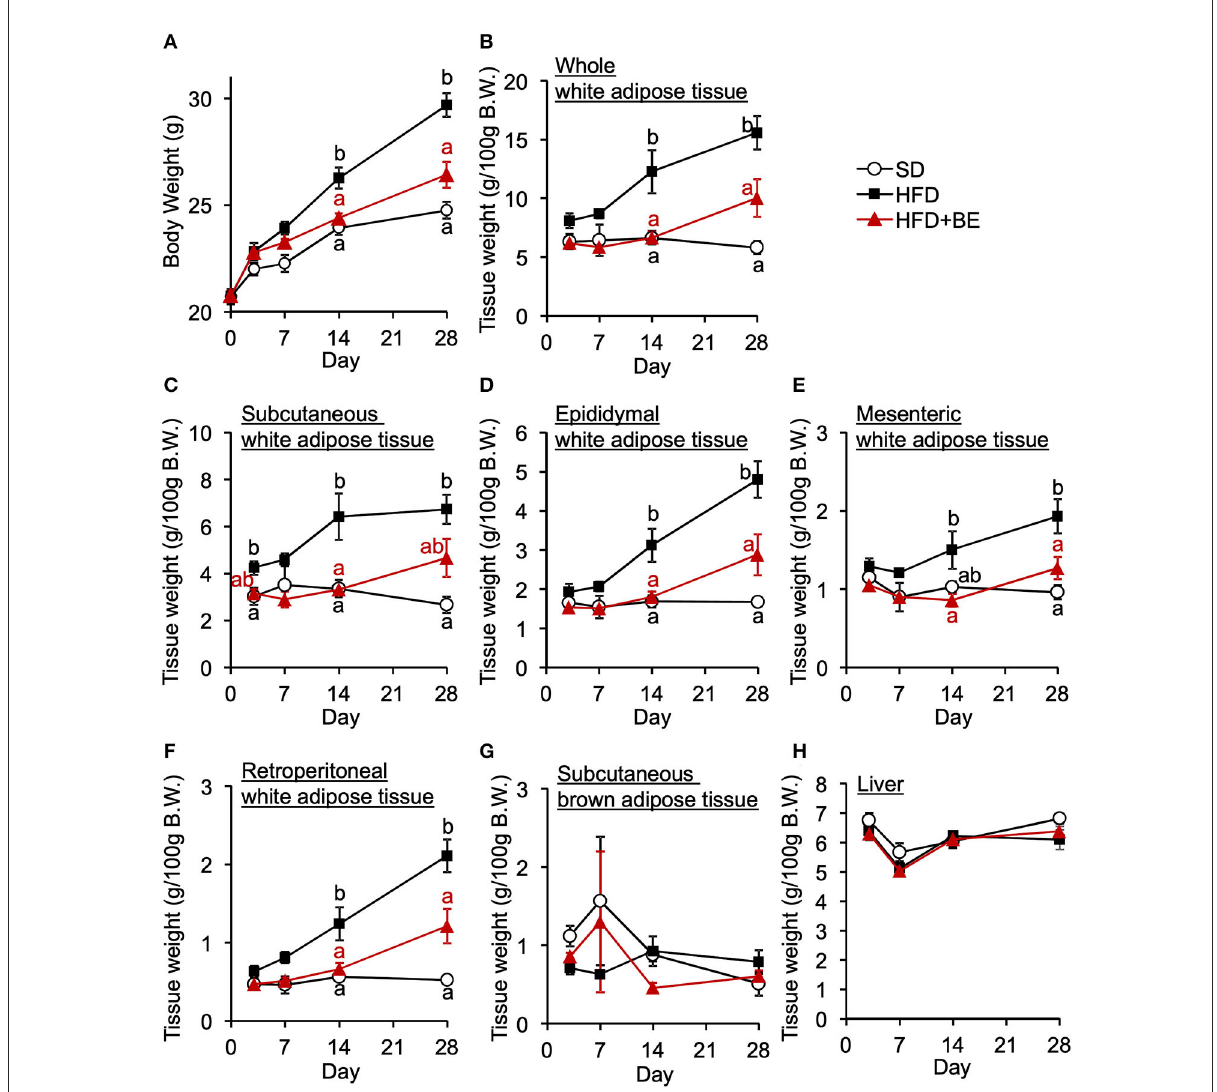
FIGURE5 Effects of HFD and BE on the gains in body and fat weight. (A) Changes in body weight in each group during the 4-week experimental period. n = 8. Weight of (B) total white adipose tissue depots, (C) subcutaneous white adipose tissue, (D) epididymal white adipose tissue, (E) mesenteric white adipose tissue, (F) retroperitoneal white adipose tissue, and (G) subcutaneous brown adipose tissue at each experimental period. n = 5. (H) Liver weight at each experimental period. n = 5. Data shown are mean ± SE. Different letters represent significant differences among the three groups by each experimental period by Tukey-Kramer honestly significant difference test ( p <